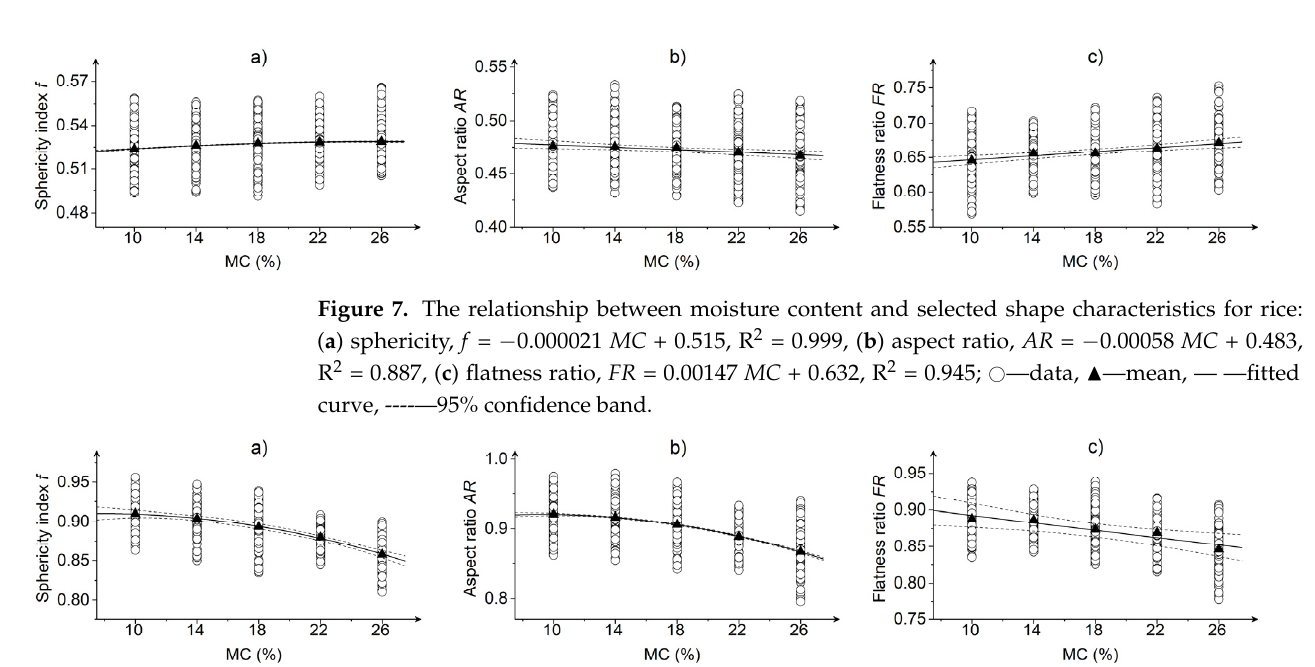
Figure 8. The relationship between moisture content and selected shape characteristics for soybeans: ( a ) sphericity, f = − 0.000158 MC 2 + 0.00249 MC + 0.900, R 2 = 0.998, ( b ) aspect ratio, AR = − 0.000193 MC 2 + 0.00357 MC + 0.904, R 2 = 0.999, ( c ) flatness ratio, FR = − 0.00254 MC + 0.918, R 2 = 0.891; ○ —data, ▲ —mean, ─ —fitted curve, ----—95% confidence band. Table 3. Results of correlation analysis between moisture content and selected shape characteristics (based on average values). Sphericity Aspect Ratio Flatness Ratio Pearson Corr. 0.960 * 0.884 * − 0.934 * Maize p -value 0.009 0.047 0.020 Pearson Corr. 0.953 * − 0.942 * 0.972 * Rice p -value 0.012 0.017 0.006 Pearson Corr. − 0.973 * − 0.965 * − 0.944 * Soybeans p -value 0.005 0.008 0.016